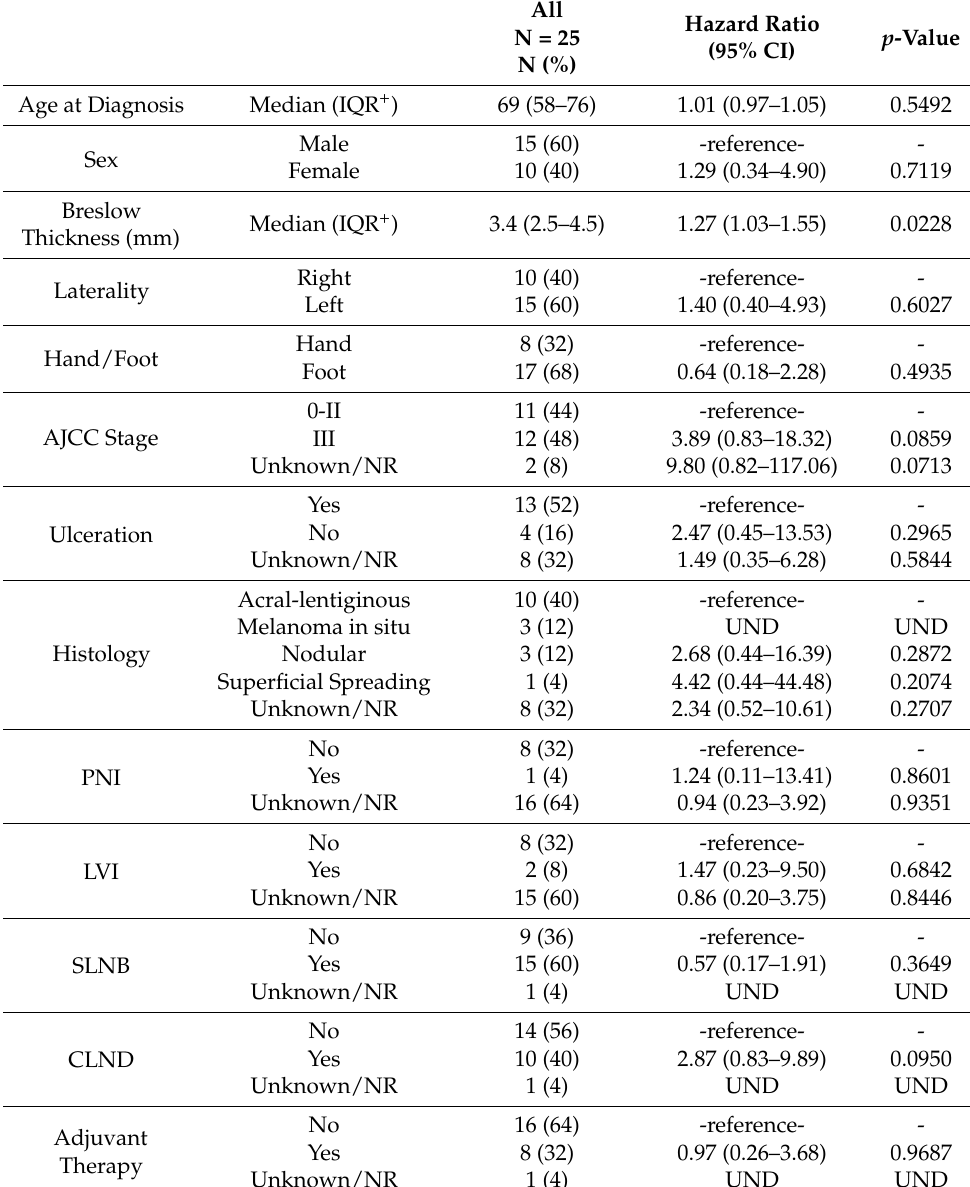
Table 2. Univariate Cox Proportional Hazards on Recurrence Free